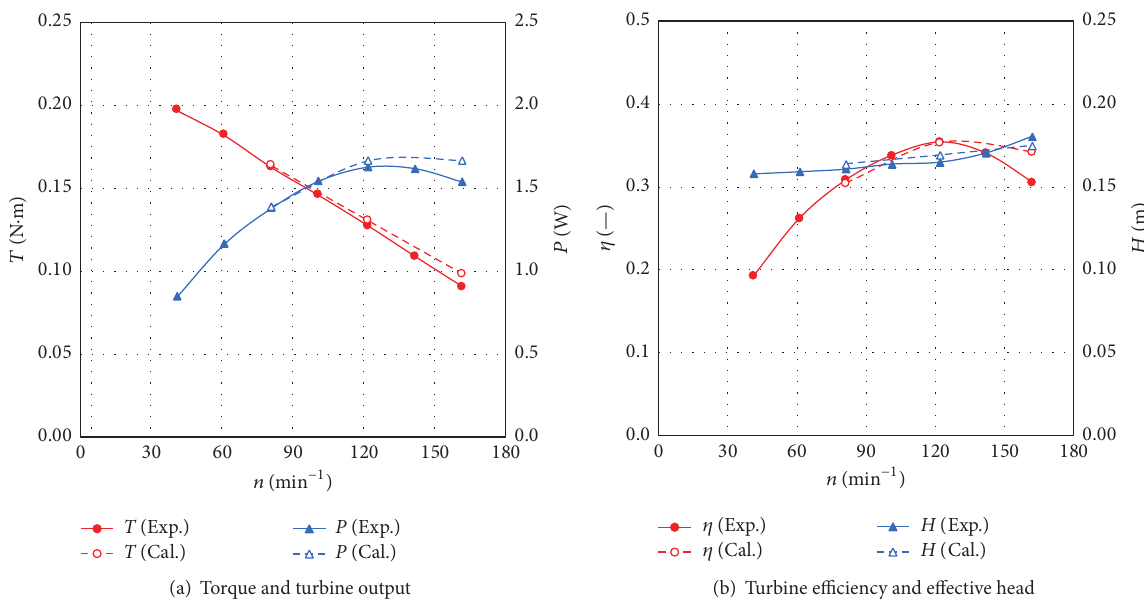
Figure 7: Turbine